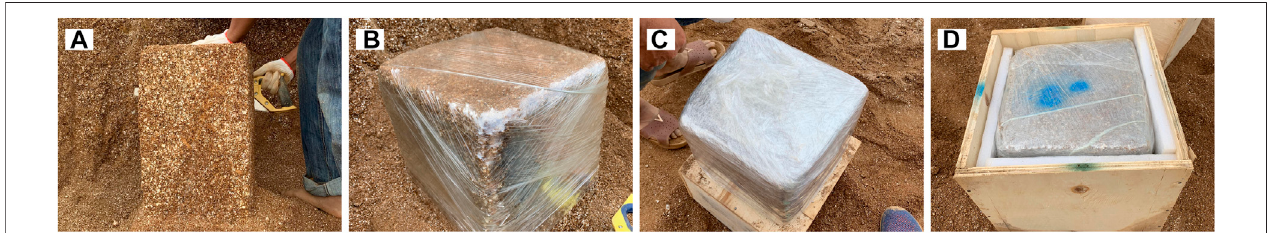
FIGURE 2 | Photos of in-situ sample collection.